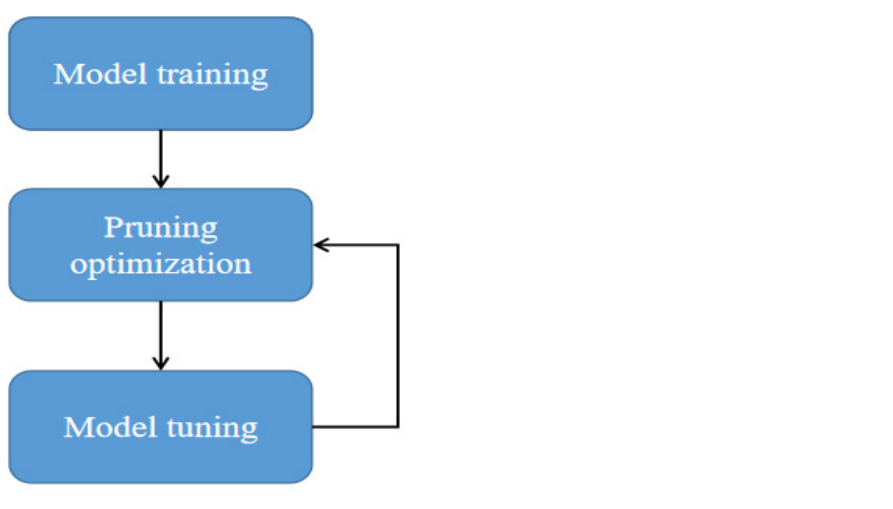
Figure 8. Model pruning process, to ensure accuracy, the model used in this paper is optimized twice.